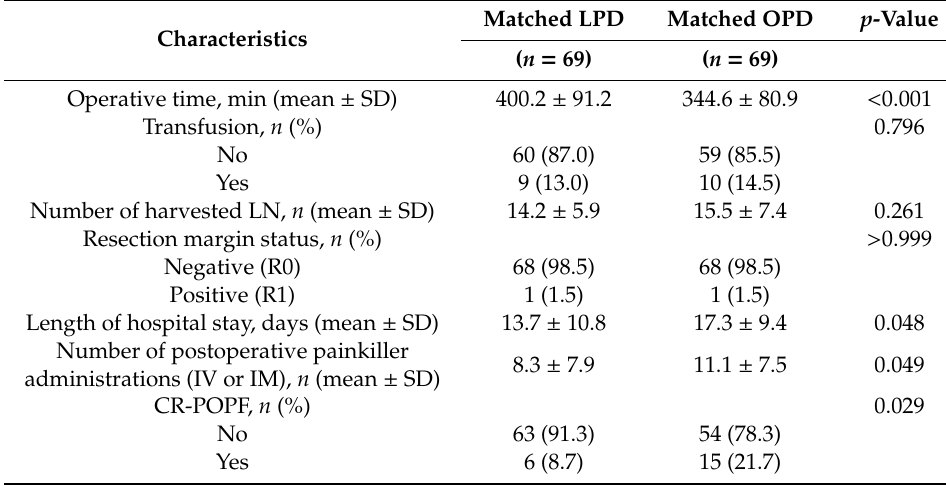
Comparative analysis of operative outcomes and complications for laparoscopic pancreaticoduodenectomy (LPD) and open pancreaticoduodenectomy (OPD) groups after propensity score